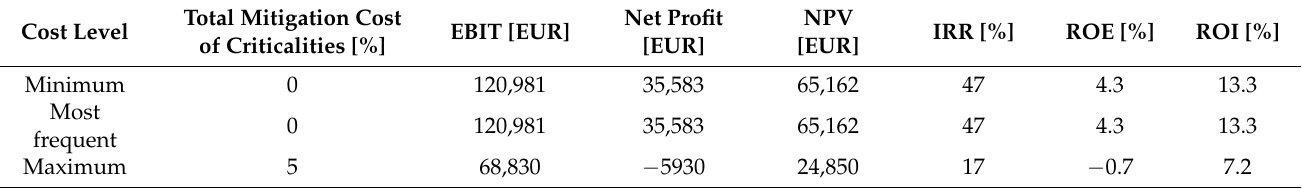
Table 12. Results of the sensitivity analysis conducted considering levels of criticality similar to those found on small real estate units and assuming critical mitigation costs equal to the minimum, maximum, and most frequent values.